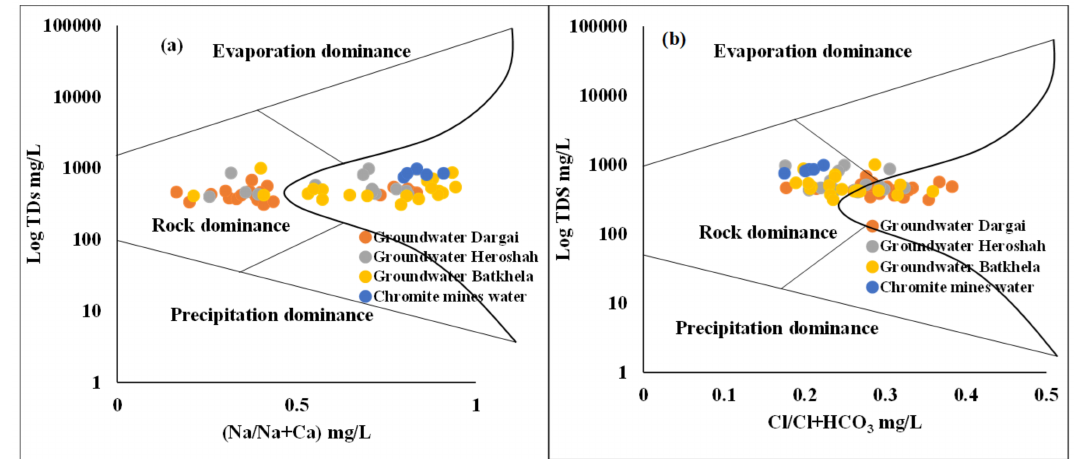
Figure 2. Gibbs plot representing major ion chemistry controlling the groundwater sources of the ultramafic terrain of Malakand, Northern Pakistan: ( a ) Na/Na + Ca and ( b ) Cl/Cl + HCO 3 mg/L versus Log TDS.